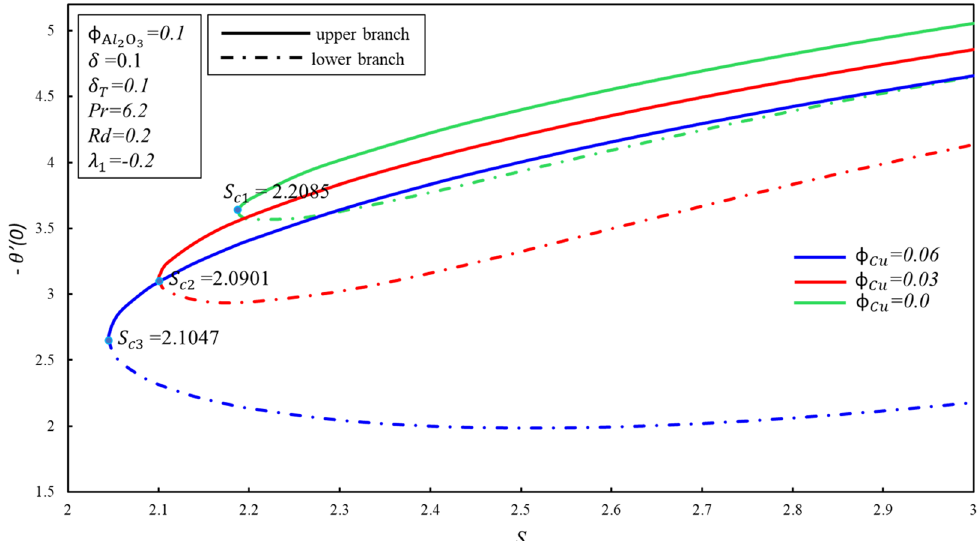
Figure 3. Behavior of